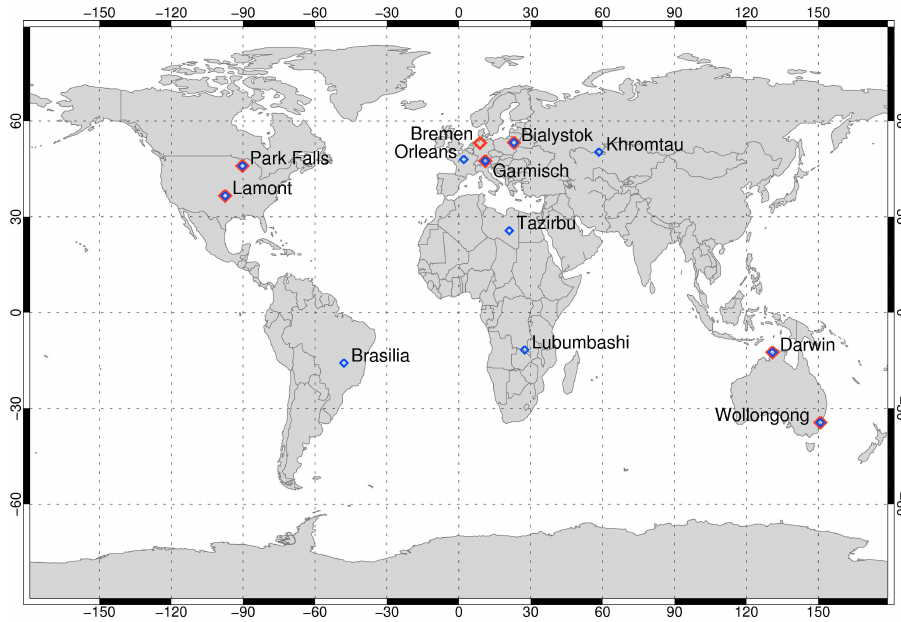
Fig. 6. Locations analysed in this study. The red diamonds show the locations used for the comparison of WFMD versions 2.1 and 2.2 with FTS measurements. The blue diamonds show the locations used for the determination of the monthly regional-scale scatter of the data in Sect. 4.2. Table 2. Scatter of the WFMDv2.1 and v2.2 XCO 2 data products at several locations and overall (MEAN). Monthly regional-scale scatter of the data Location Country Lat [ ◦ ] Lon [ ◦ ] WFMDv2.1